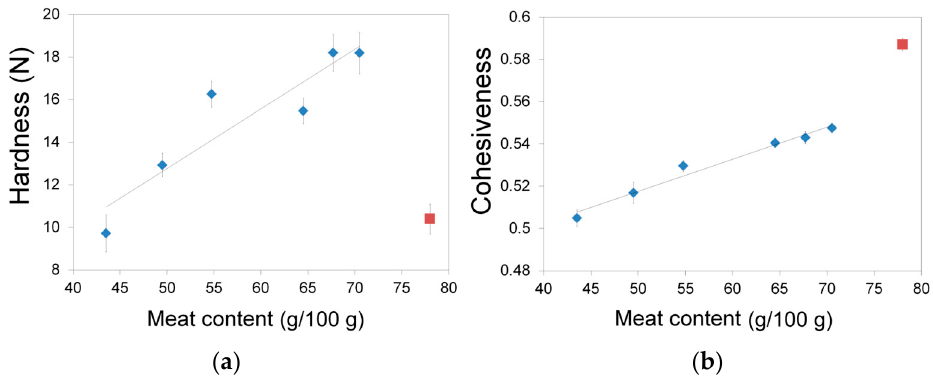
Figure 2. Burger´s hardness ( a ) and cohesiveness ( b ) variation with the pork meat content. ( ♦ ) BF-B; ( ■ ) C-B; (–) linear regression. ( (cid:4) ) C-B; (–) linear